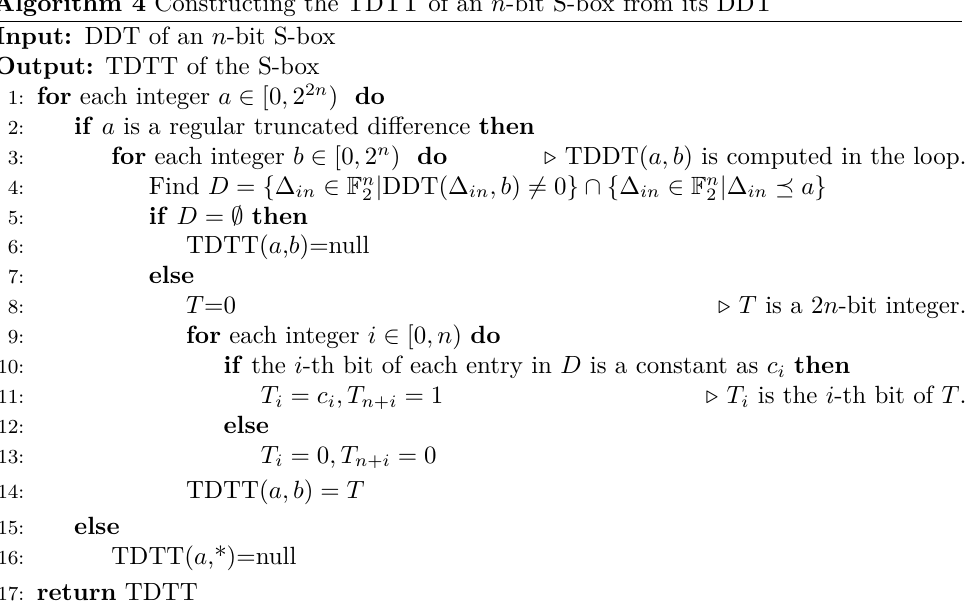
Algorithm 4 Constructing the TDTT of an n -bit S-box from its DDT